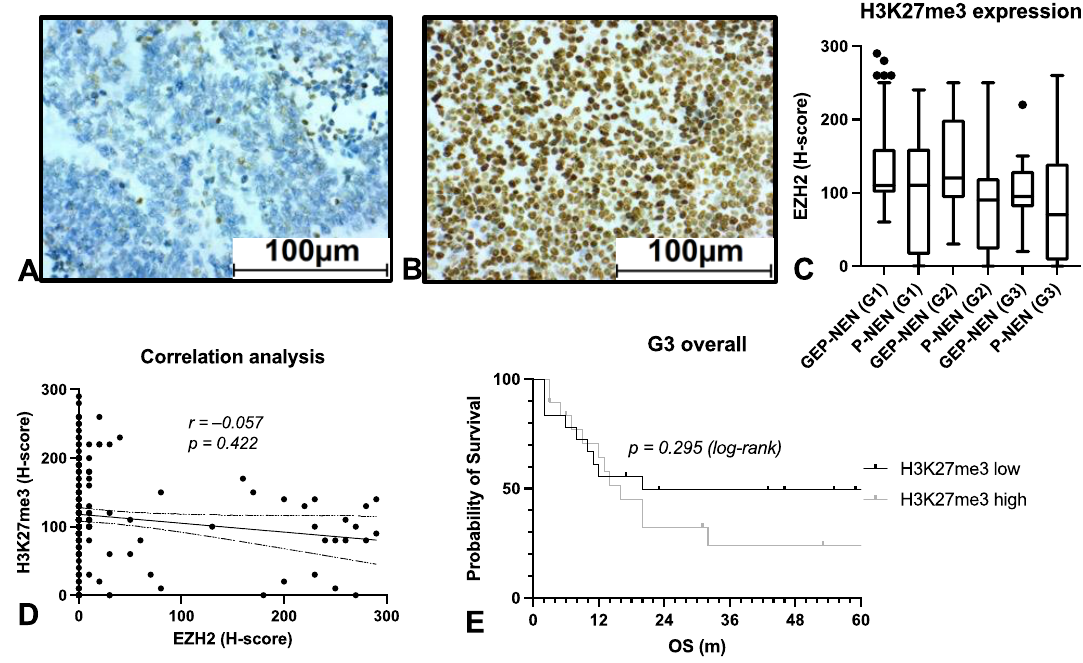
Figure 4. H3K27me3 expression in NEN. H3K27me3 staining was performed in all specimens. ( A )